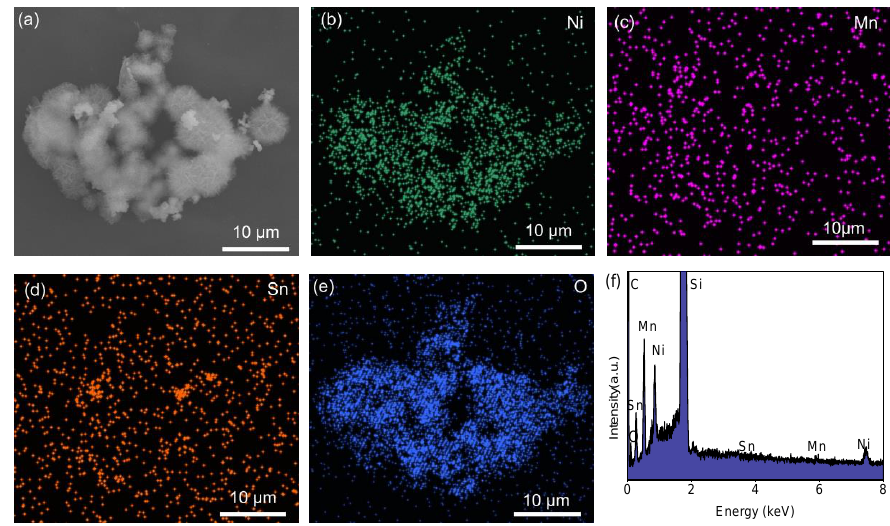
signal of Si is ascribed to the substrate used for measurement [37]. The profiles of Mn and Sn do not match well with the profile, which could be caused by the covering of signals by Ni and O, as has previously been reported in some surface-coated composites [38].